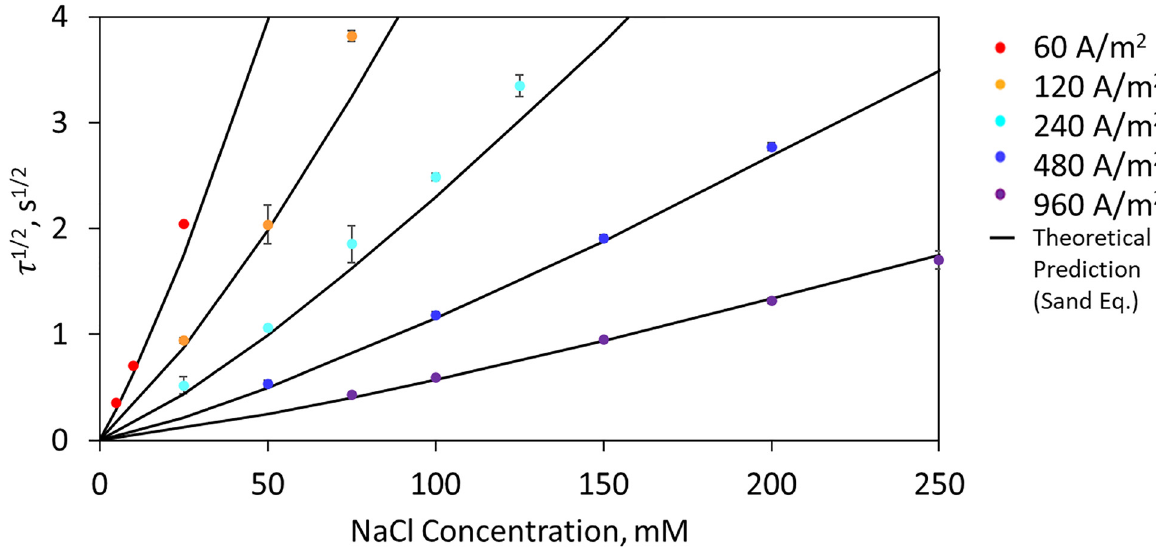
Figure 4. The experimental and theoretical (black line) square root of transition time (N = 3) as a function of chloride concentration in 20 mM Na 2 SO 4 at 25 °C. One current density does not resolve the entire relevant concentration range of 5–250 mM NaCl.